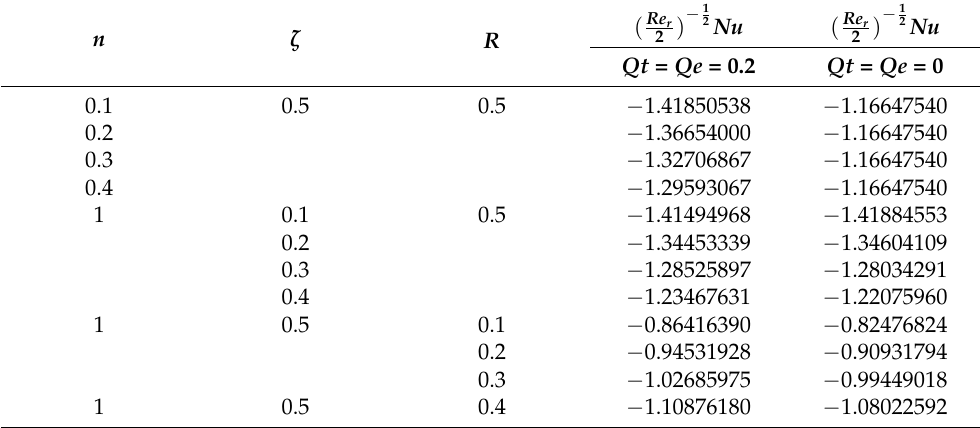
− 1 ) 2 Nu , for different values of Qe and Qt by setting R = 0.5, n = 1, ζ = 2